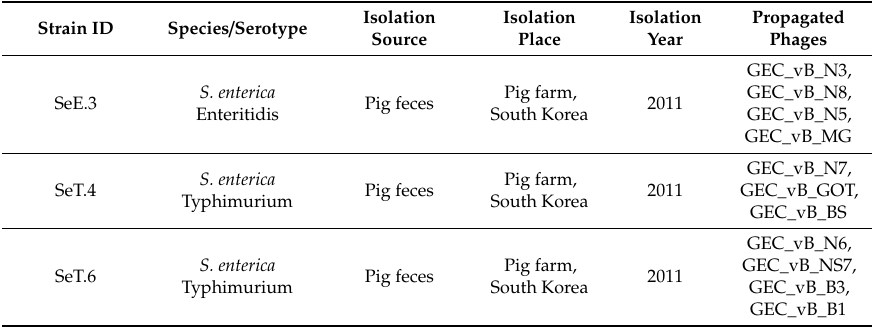
Table 3. Bacterial strains used for propagation of phages.